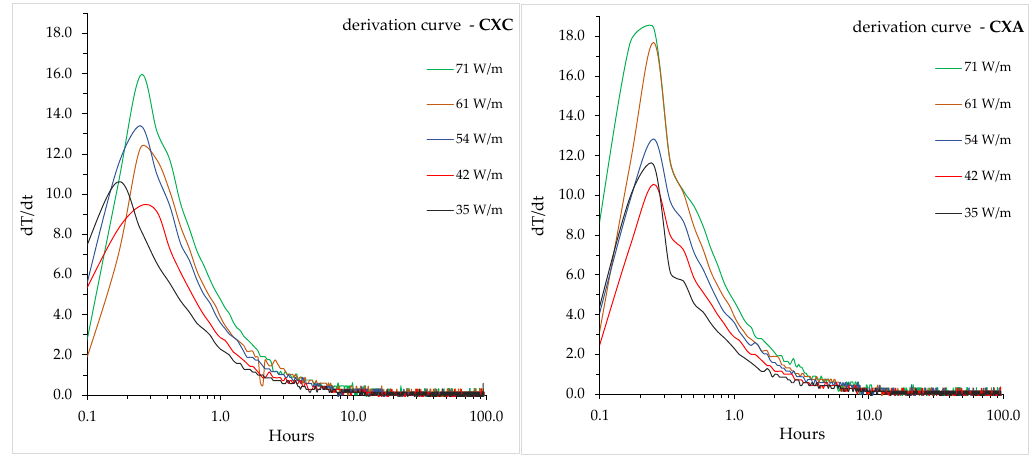
Figure 7. EST derivation curves for CXA and CXC flow arrangement and each TRT heat step.